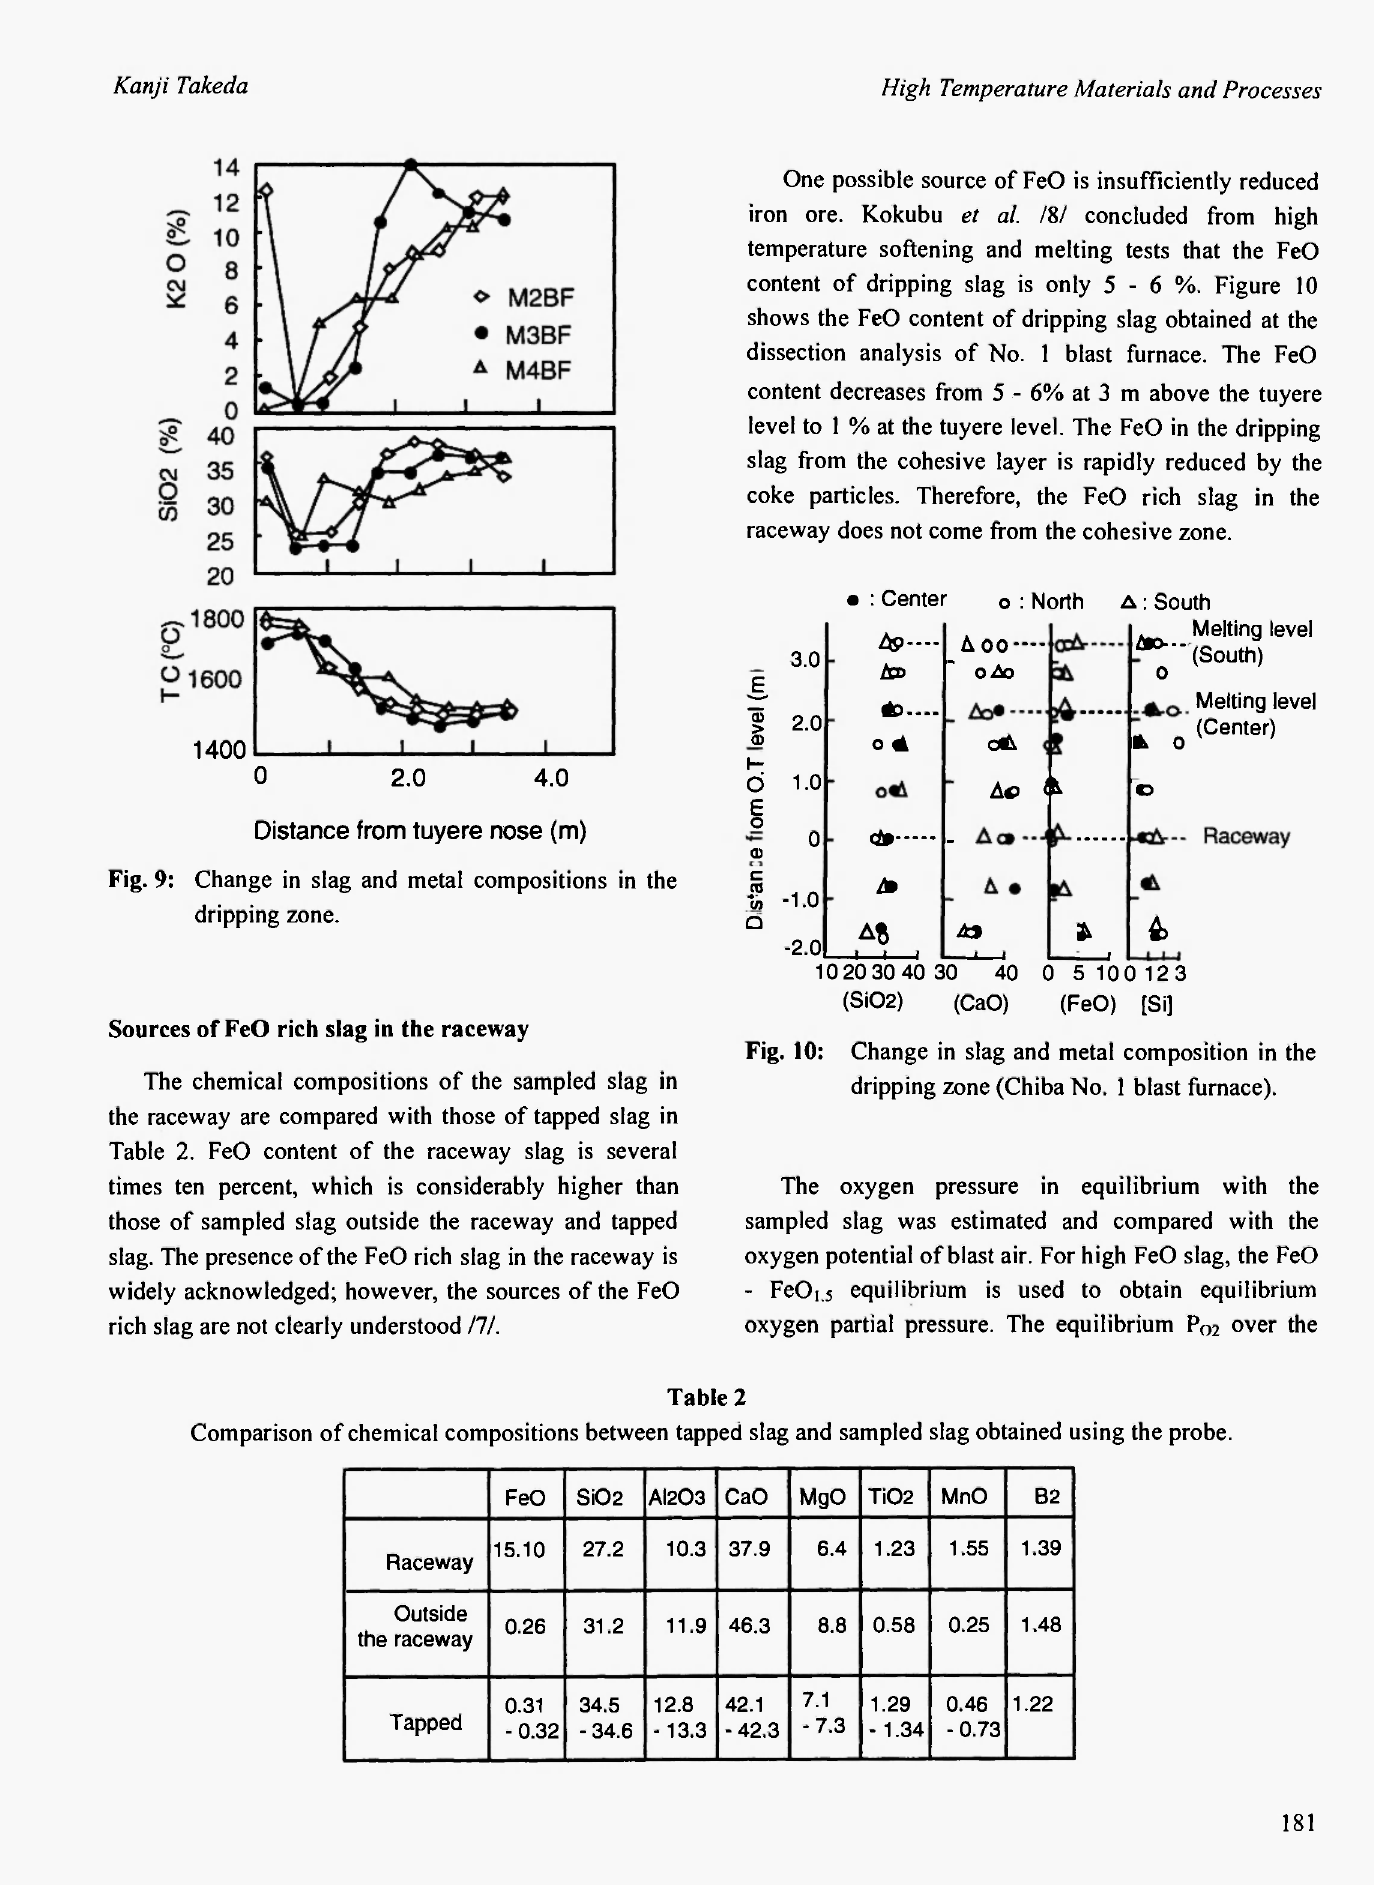
Sources of FeO rich slag in the raceway The chemical compositions of the sampled slag in the raceway are compared with those of tapped slag in Table 2. FeO content of the raceway slag is several times ten percent, which is considerably higher than those of sampled slag outside the raceway and tapped slag. The presence of the FeO rich slag in the raceway is widely acknowledged; however, the sources of the FeO rich slag are not clearly understood 111.